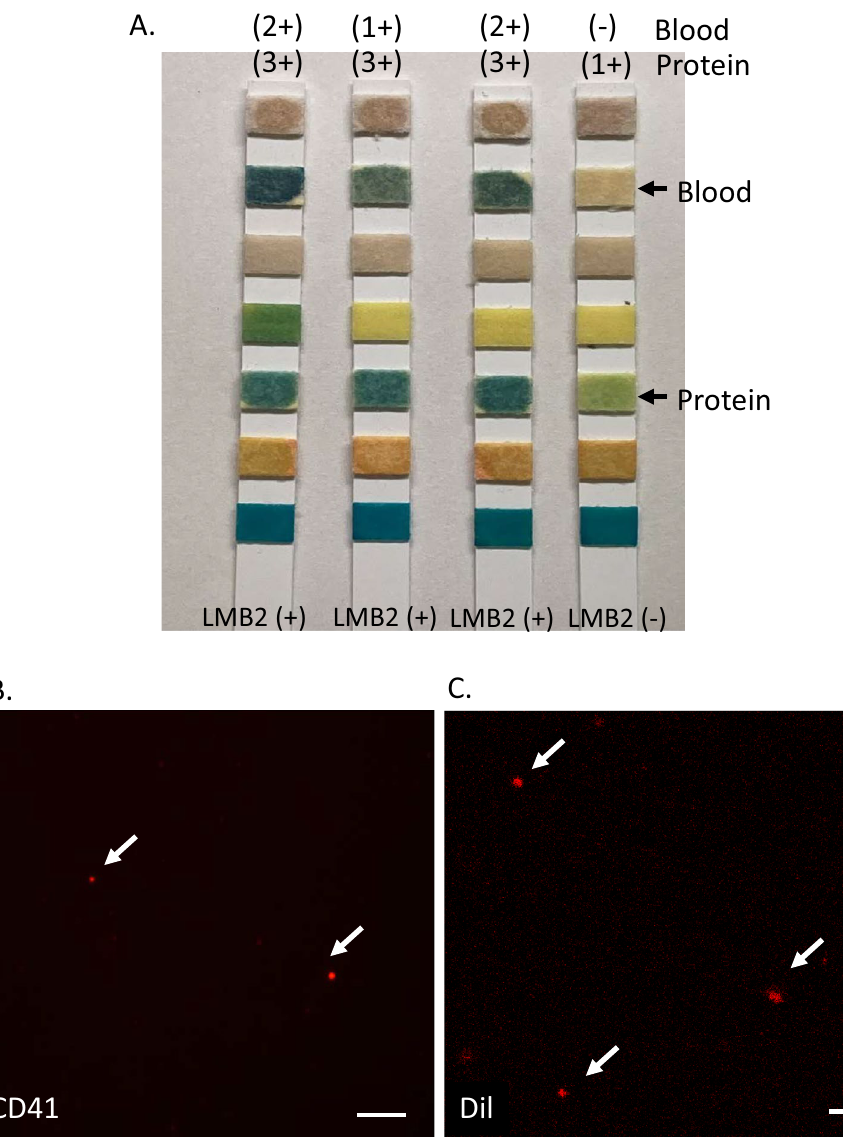
Figure 3. Detection of urinary platelets in podocyte injured mice. ( A ) Urinary protein and occult blood were detected by urine test strip in the urine 5 days after LMB2 injection [LMB2 (+)]. Those reactions were negative for LMB2-untreated mice [LMB2(−)]. Blood changes white paper to green, and protein changes yellow paper to green. Note that normal mice show 1 + proteinuria due to high concentration of small molecular weight proteins. ( B ) Confocal microscopy of Cy3-CD41 platelets in the urine. Immunostaining for CD41 showed platelets (arrows) were detected in the urine 5 days after LMB2 injection. Scale bar: 20 μm. ( C ) Confocal microscopy of DiI-platelets in the urine. DiI labeled platelets (arrows) were detected in the urine of mice injected with DiI platelets 5 days after LMB2 injection. Scale bar: 20 μm. Positive and negative control images for ( B ) and ( C ) are shown in supplementary Fig.